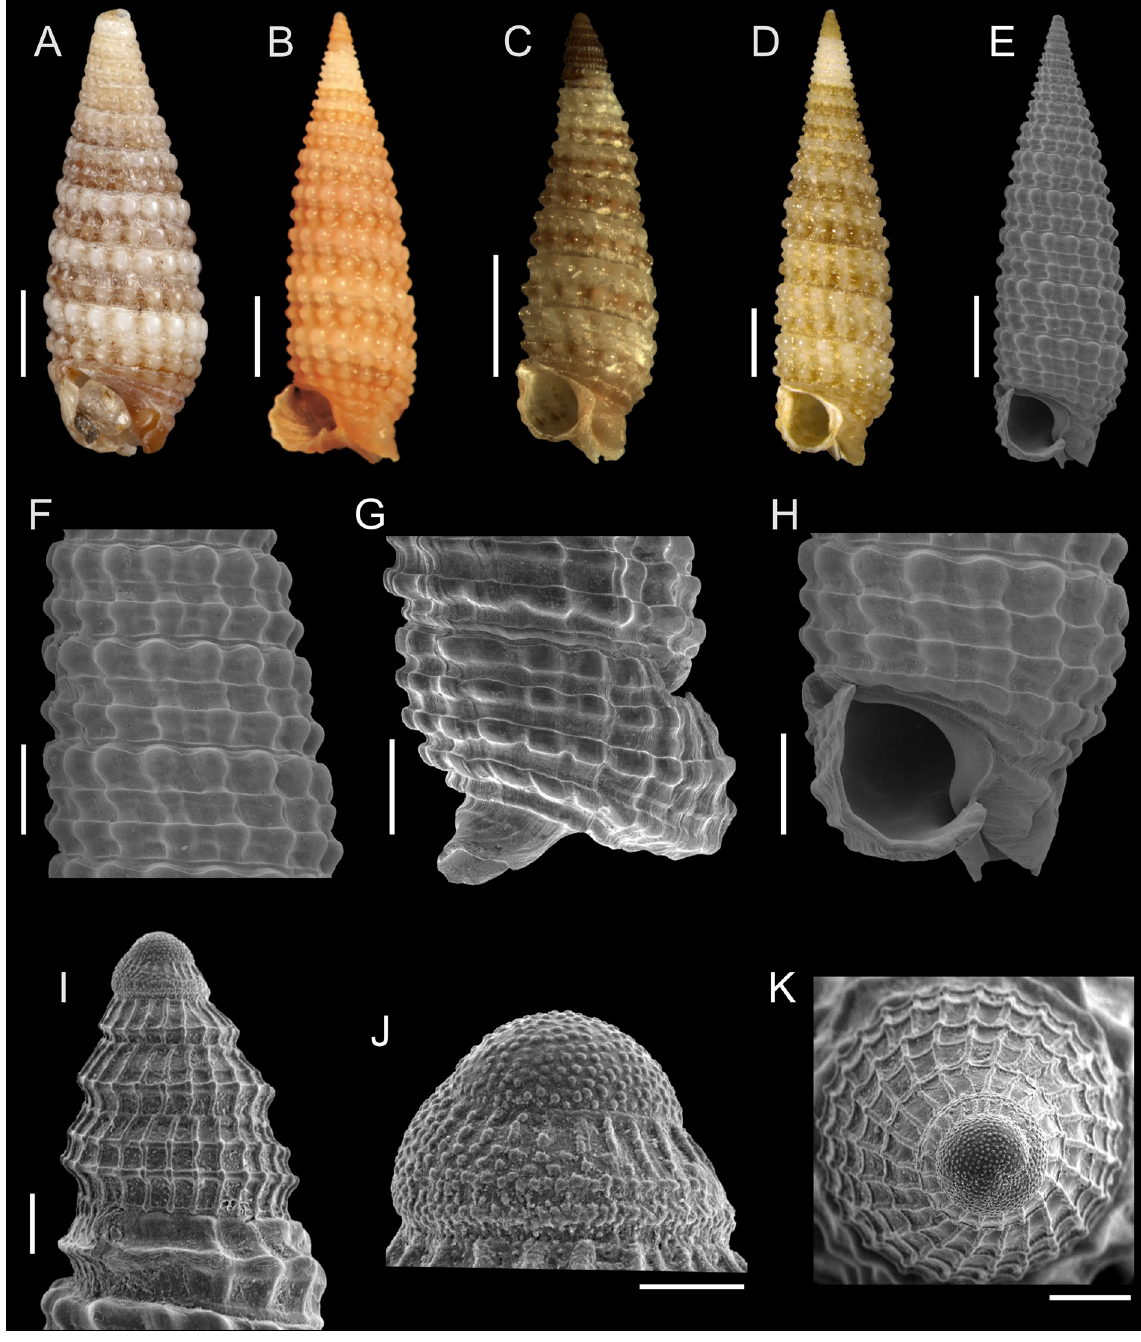
Fig. 95. Triphora atlantica Smith, 1890. A . Lectotype, NHM 1889.10.1.1374. B . MNRJ 18693*, 5.63 mm. C . MNRJ 18972*, 3.71 mm. D . MNRJ 31984*, 6.65 mm. E–F, H . Same shell as B. G . Same shell as D. I–K . Same shell as C. Scale bars: A–E = 1 mm; F–H = 500 µm; I, K = 100 µm; J = 50 µm . Photo credits A: Andreia Salvador (NHM).